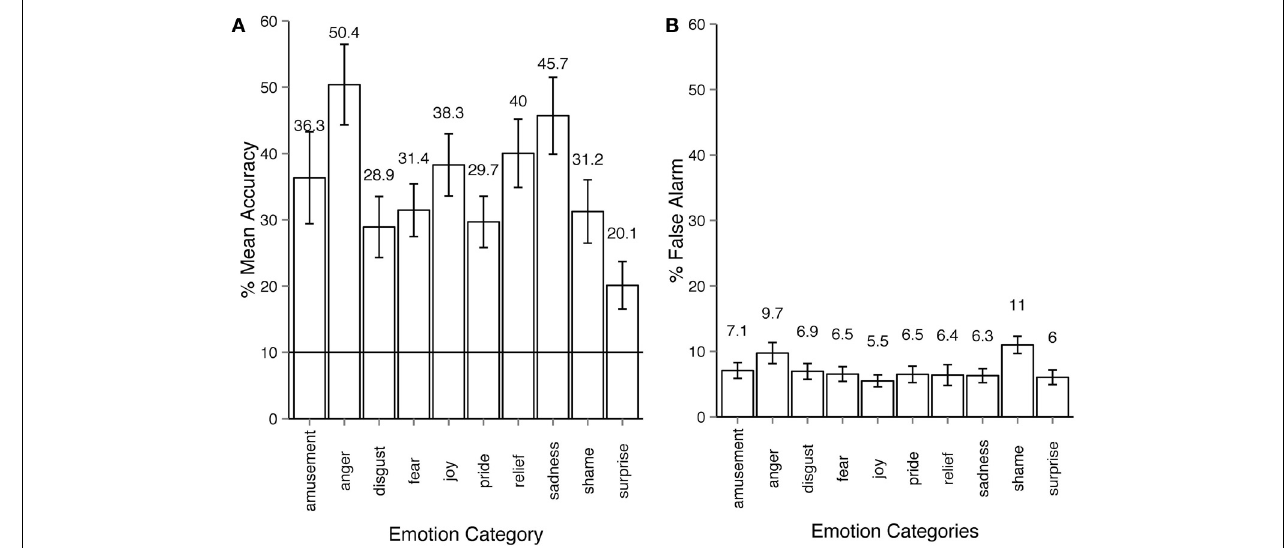
FIGURE 2 | Emotion recognition in experiment 1. (A) Accuracy across emotion categories. The horizontal line shows the chance level threshold of 10%. (B) False alarm rate across emotion categories. All error bars show 95% confidence intervals. The participant observed a stick-figure representation of human upper-body